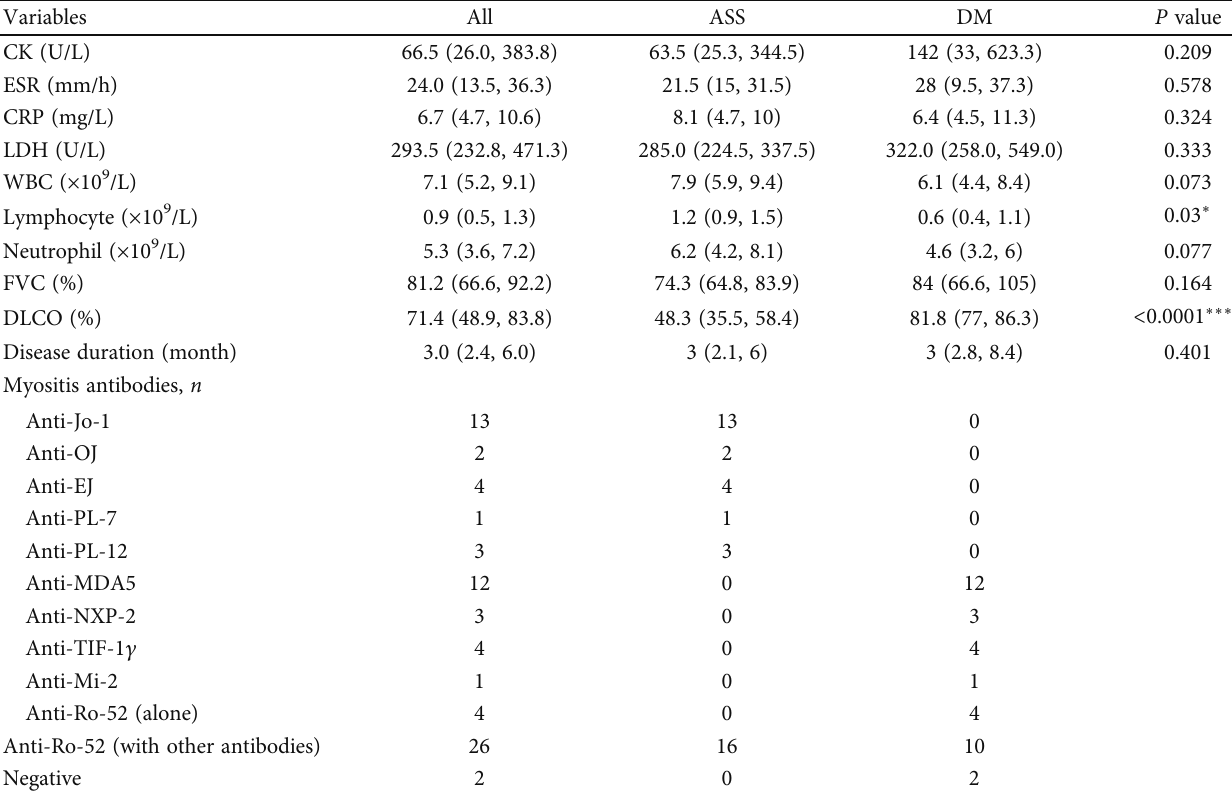
Table 2: Laboratory variants of the ASS and DM